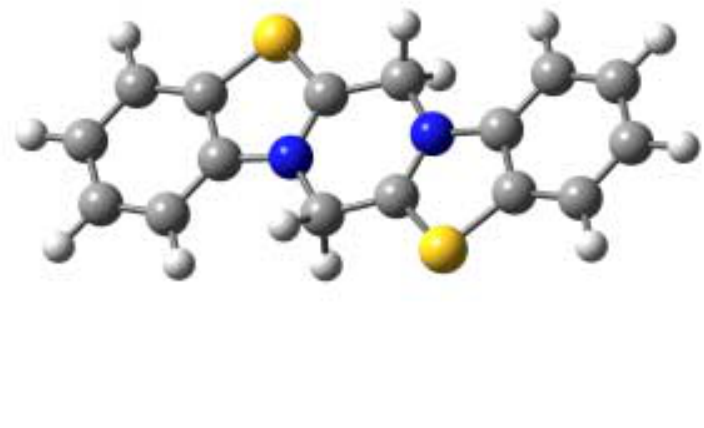
Figure 1. Calculated structure of dication 2a (bond lengths in ¯, bond angles in o